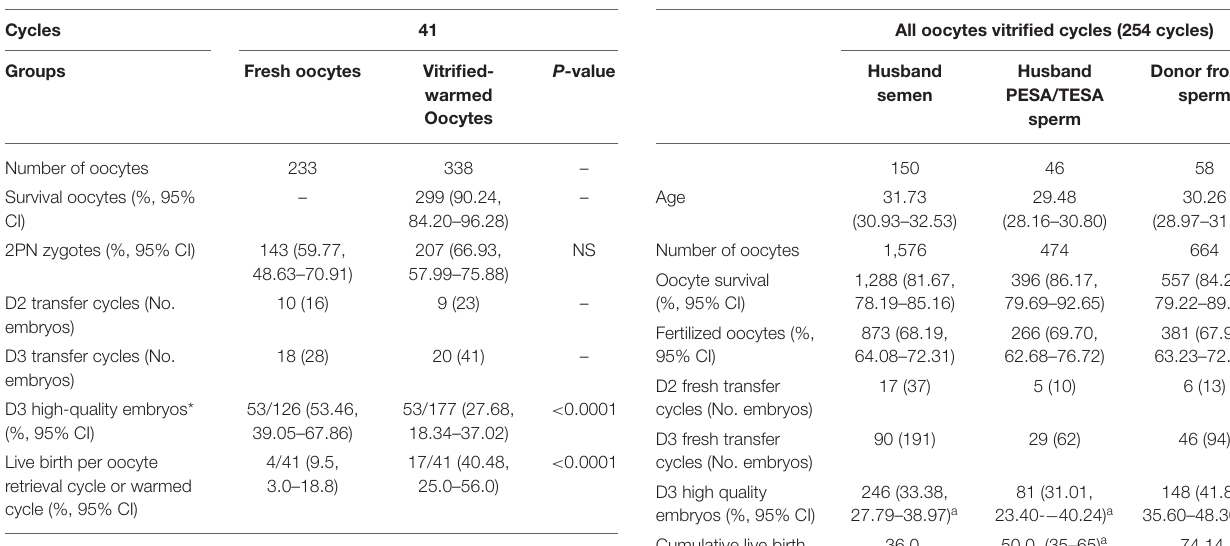
TABLE 6 | Clinical outcomes according to different sperm sources after oocyte warming in all-oocyte-vitrified cycle